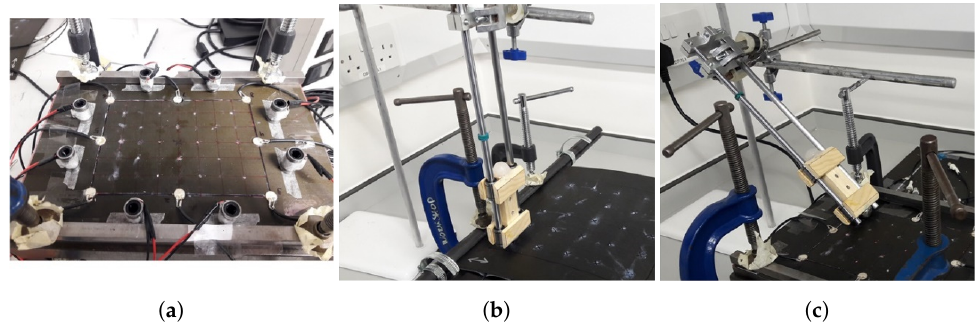
Figure 1. Experimental set-up of the apparatus for data collection showing ( a ): the flat composite plate, with the attached sensors, ( b ): rail guided impactor at 90 ◦ , and ( c ): rail guided impactor at 45 ◦ . The figure is a modified version of Figure 1 in